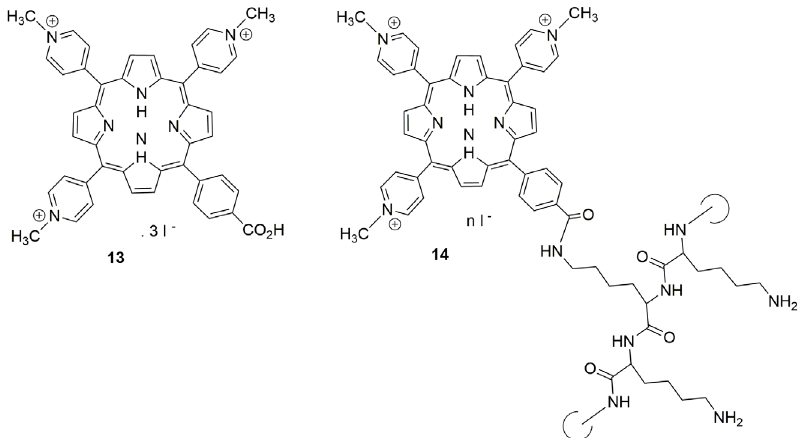
Figure 16 - Chemical structures of the poly-S-lysine conjugate 14 and of its tricationic acid precursor 13 .